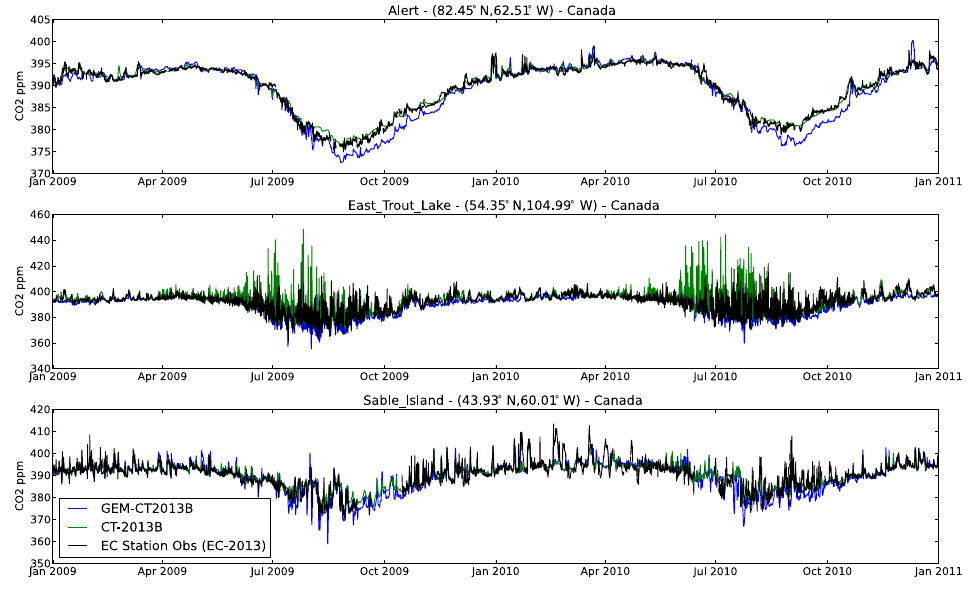
Figure 3. Comparison of GEM-MACH-GHG with surface observations at Alert (top), East Trout Lake (middle) and Sable Island (bottom). ECCC observations (black), GEM-MACH-GHG with CT2013B fluxes (blue) and CarbonTracker-2013B (green) time series are shown for each